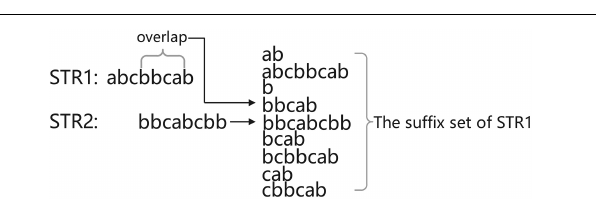
FIGURE 2 | The elements stored in three arrays.